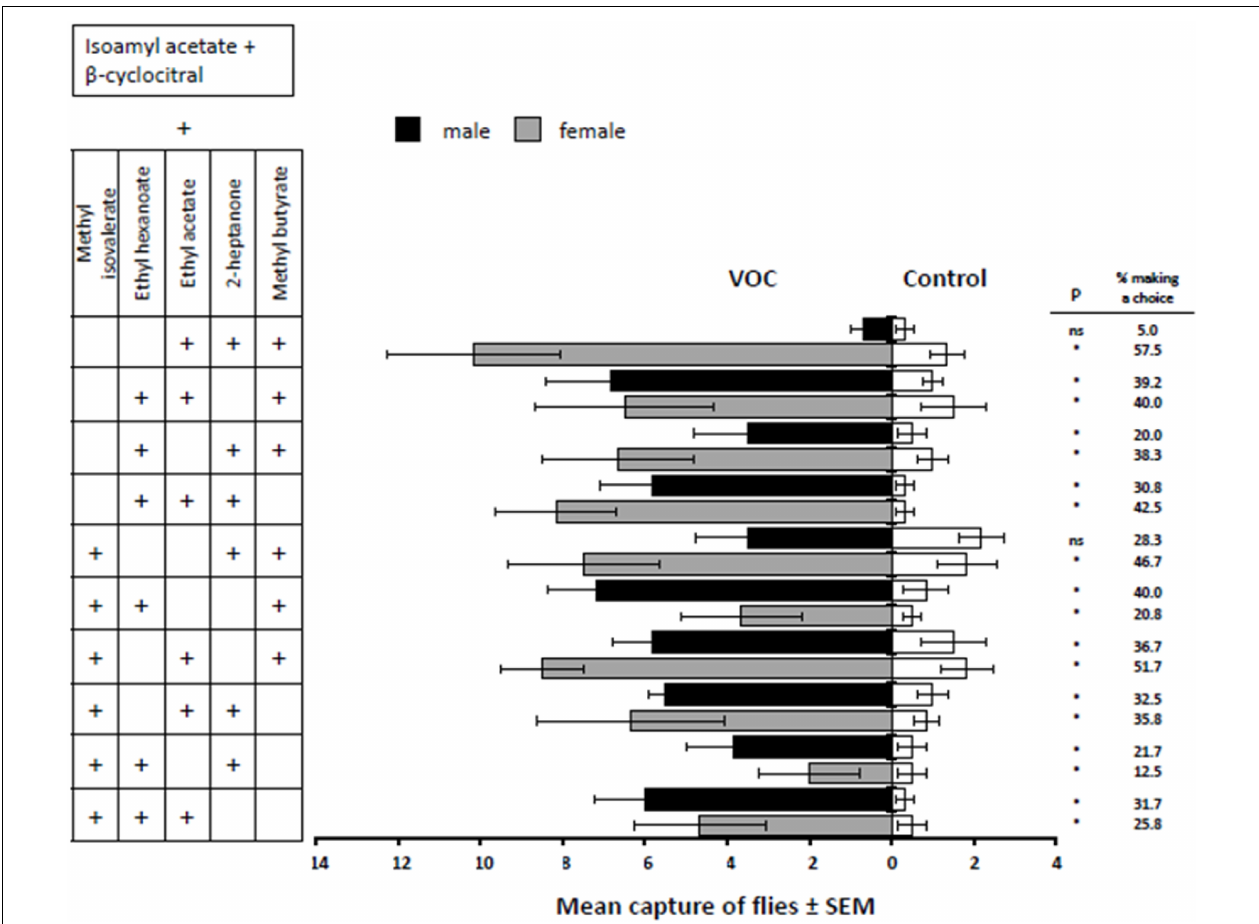
FIGURE 3 | Response of male and female D. suzukii to mixtures of three fruit volatiles added to isoamyl acetate and β -cyclocitral (VOC) against the mineral oil solvent (Control). P -values with ∗ indicate P < 0.05 and “ns” indicates a non-significant difference where P >